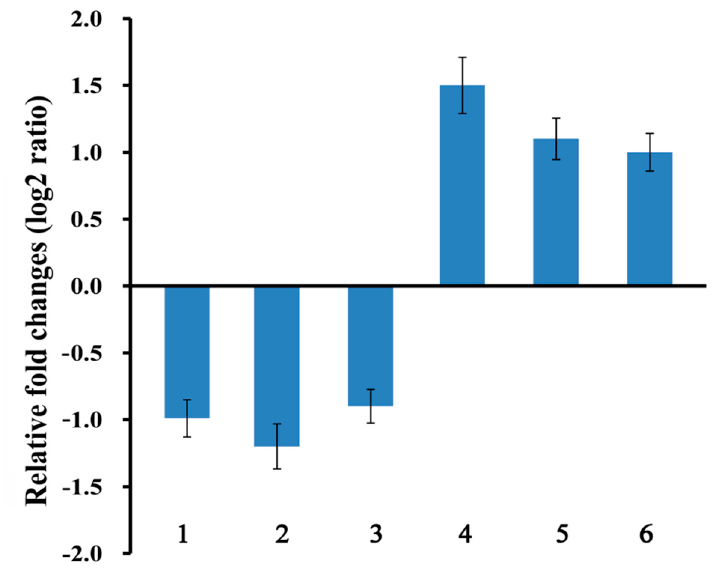
Figure 8. Comparison of the relative fold changes of six genes subjected to quantitative real-time polymerase chain reaction. Numbers 1, 2, 3, 4, 5, and 6 represent MC1005273, MC1004502, MC1000699, MC1004145, MC1000224, and MC1000519, respectively.